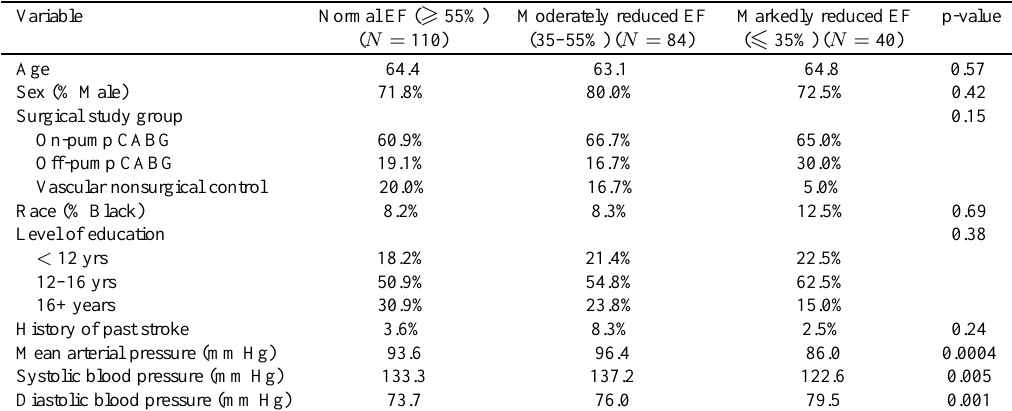
Table 2 Demographics, baseline information on individuals in 3 categories of ejection fraction